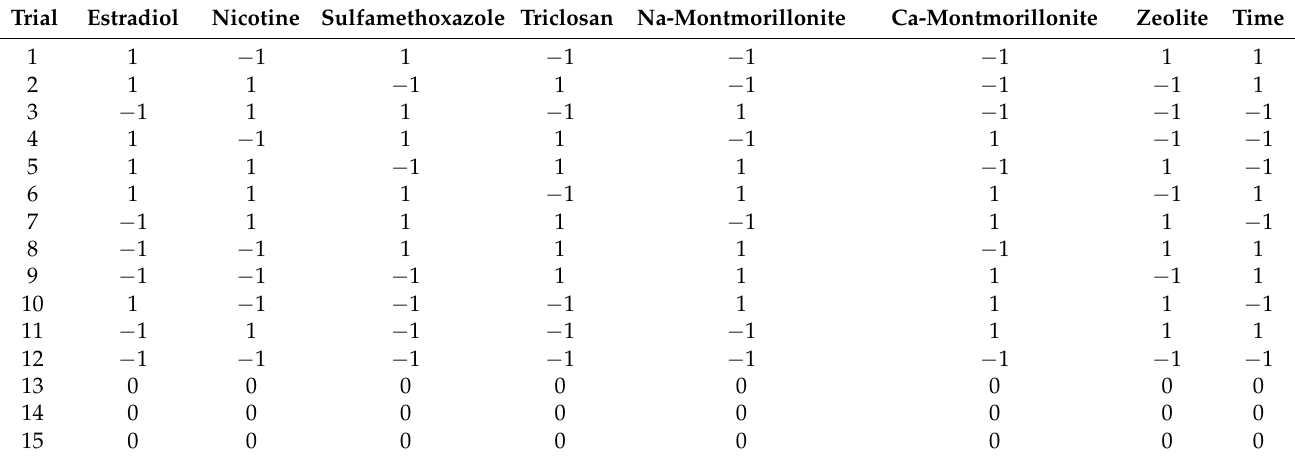
Table 4. Variable levels for each trial as applied in the Plackett–Burman